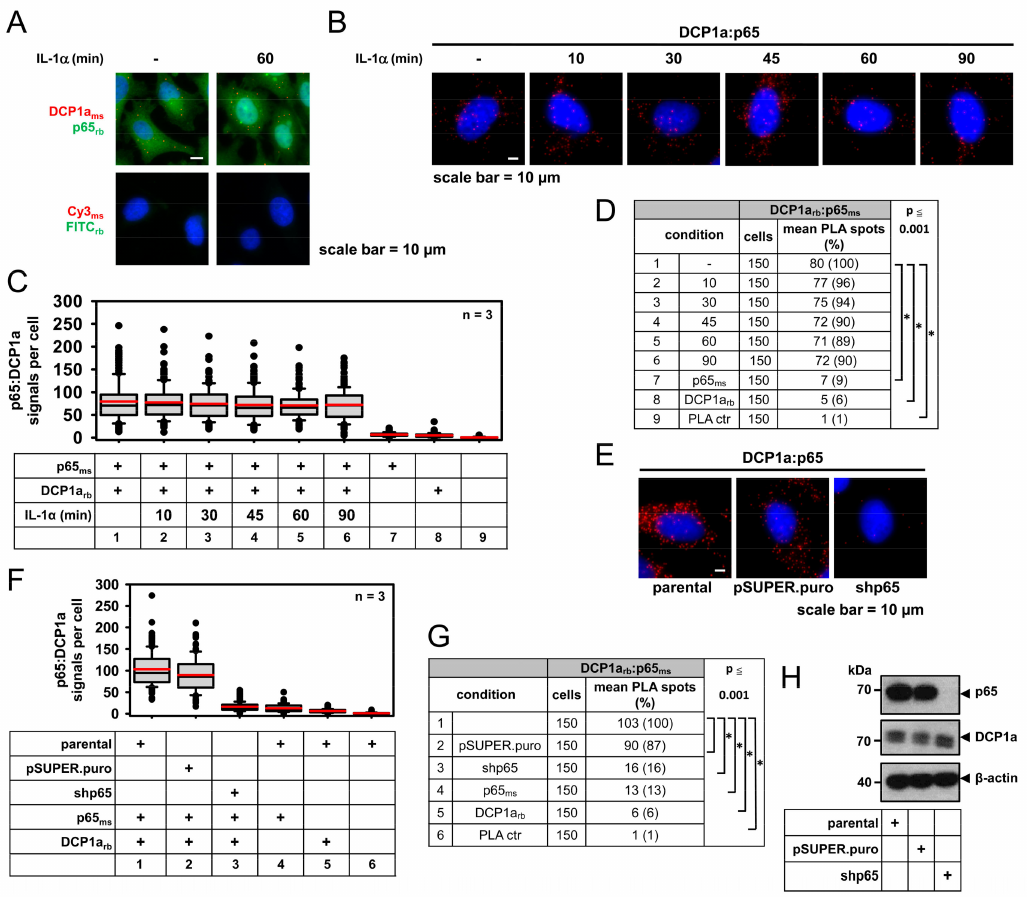
Figure 8. PLA for the validation of new p65 interactors: Analysis of endogenous NF- κ B p65 / DCP1a complexes. ( A ) Double-immunofluorescence analysis of DCP1 and p65 in HeLa cells stably